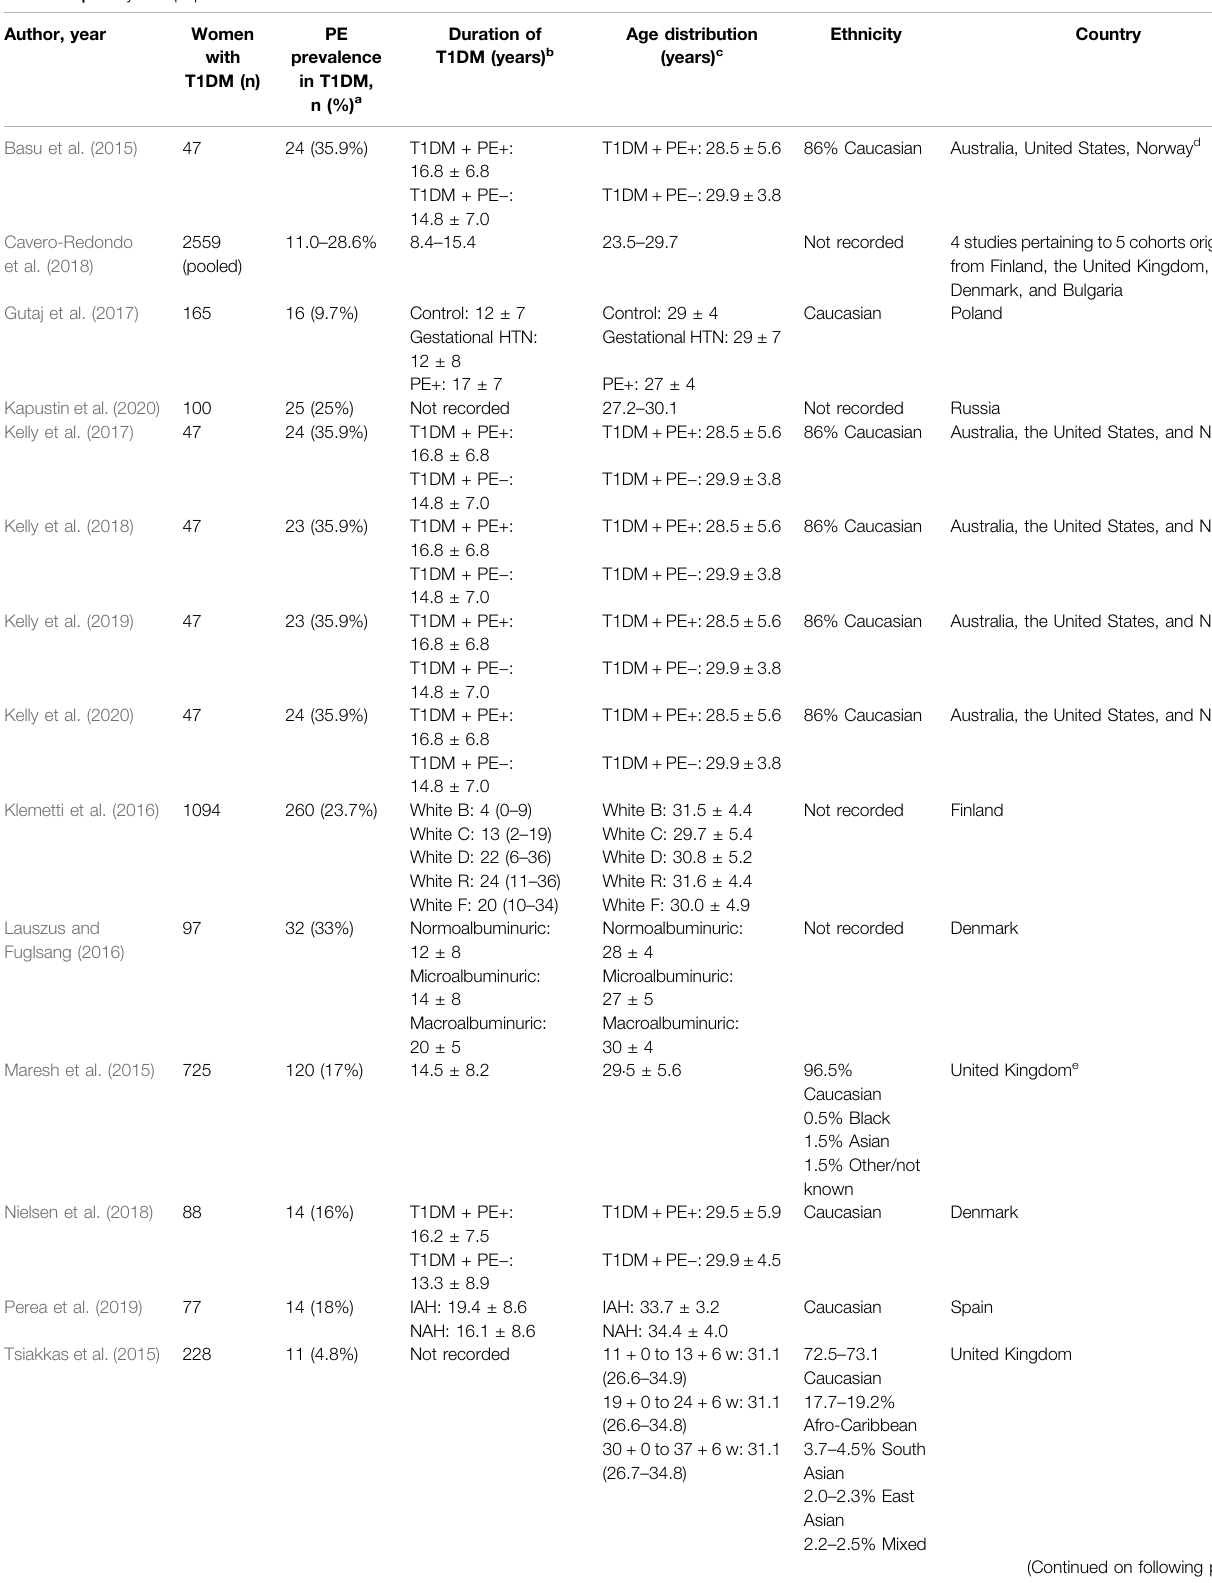
TABLE 2 | Study and population